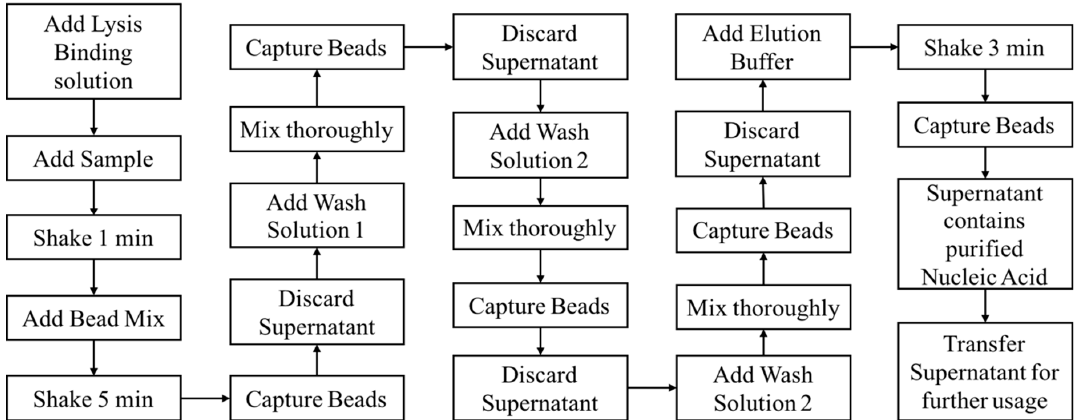
Figure 1. Protocol for nucleic acid extraction using the magnetic bead method.